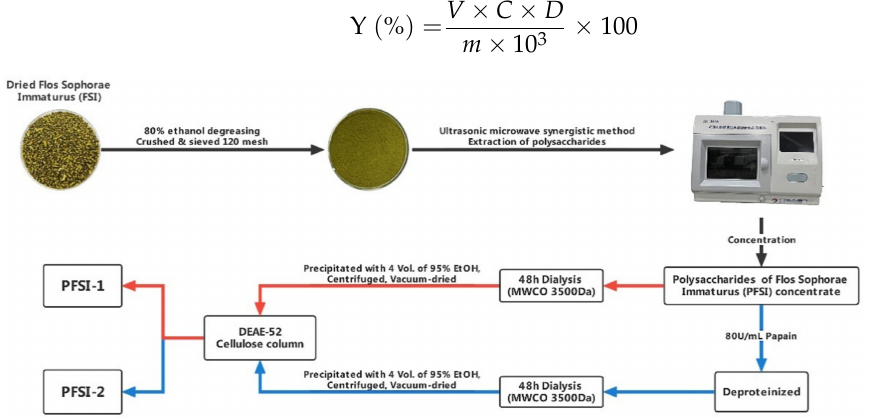
Figure 1. The procedure for the extraction and purification of PFSI-1 and